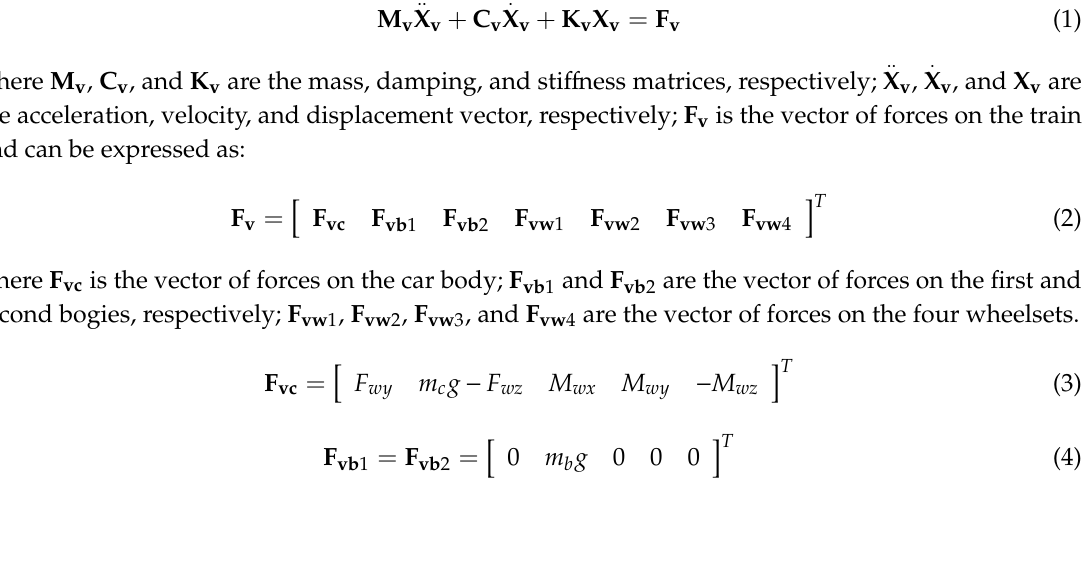
Figure 2. High-speed vehicle model: ( a ) side elevation, ( b ) plan view, and ( c ) end view. Table 1. Value of the main parameters of the vehicle subsystem.